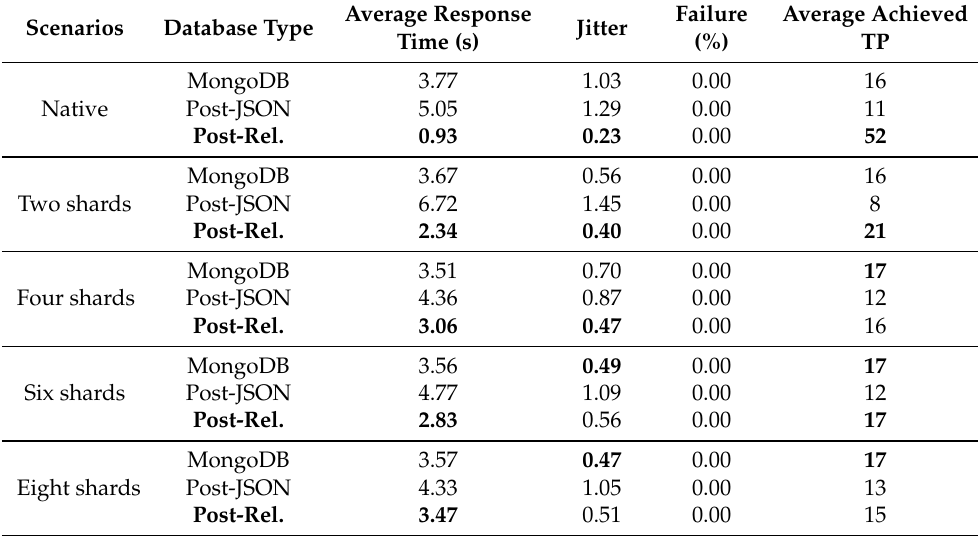
Table 3. Average of response time and throughput, jitter and failure in MongoDB, Postgres JSON and Relational PostgreSQL for the representative case of 10 K client throughput in the correlation (Q3)